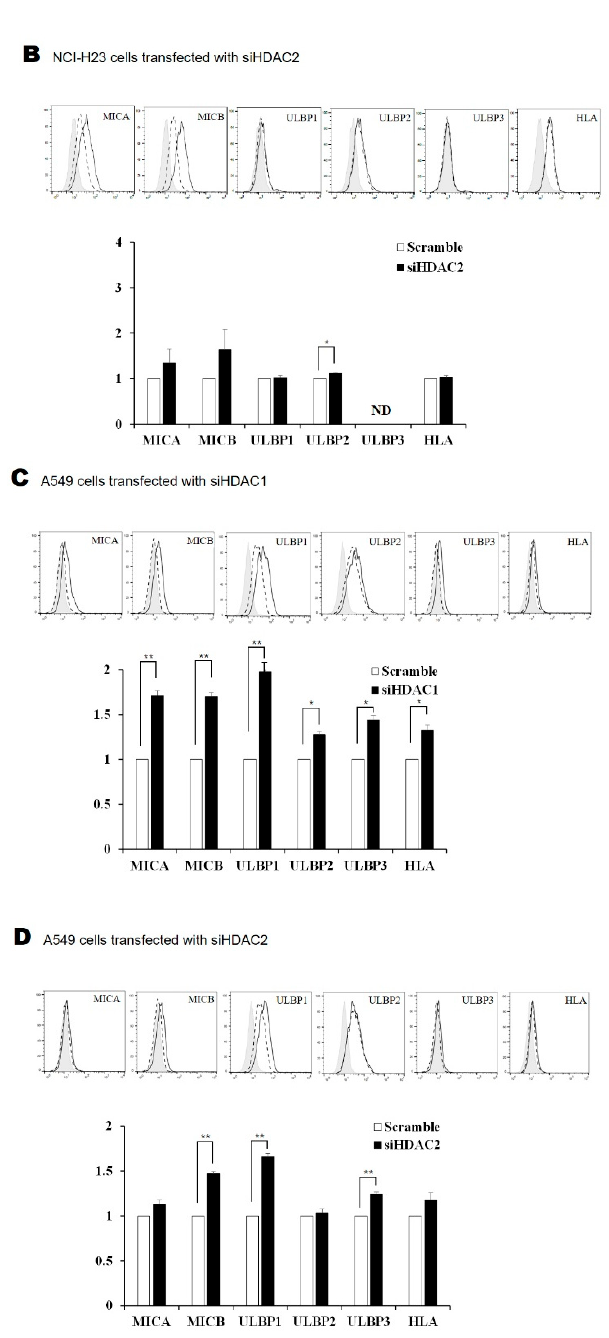
Figure 4. Surface expression of NKG2D ligands after HDAC1 or HDAC2 silencing. Surface protein expression of NKG2D ligands was analyzed using flow cytometry 48 h after transfecting NCI-H23 ( A , B ) and A549 cells ( C , D ) with siH1 or siH2. The solid gray, dotted, and black lines represent isotype control, scRNA, and siRNA, respectively. * represents a statistically significant increase. p -values less than 0.05 and 0.01 are marked as * and ** symbols, respectively. ND means not de- tected.